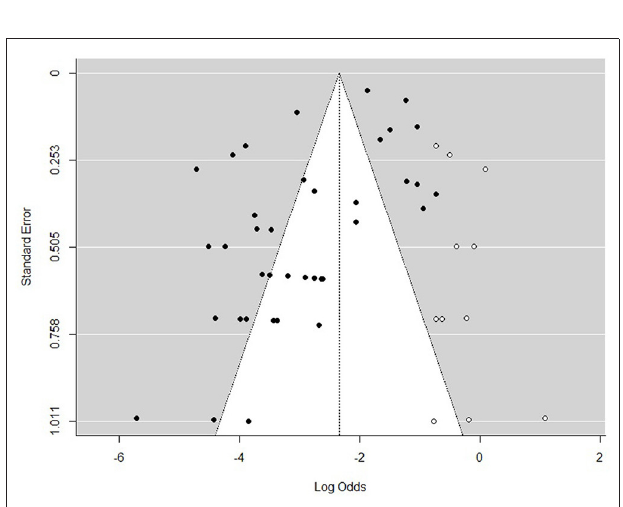
FIGURE 6 | Funnel plot of publication bias of prevalence of Klebsiella spp.